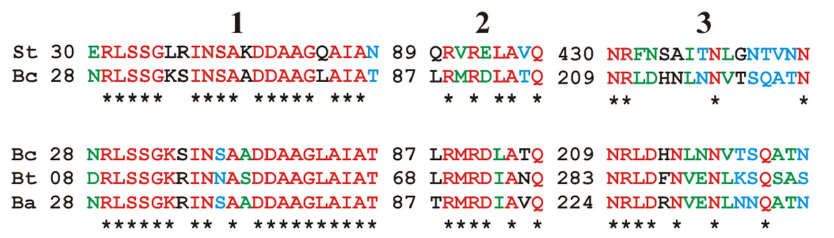
Figure 7. Multiple sequence alignments of S.typhimurium , B.cereus , B.thuringiensis , and B.anthracis flagellins. The amino acid sequences of B. cereus (Bc) and S. typhimurium (St) (top) and Bc, B. thuringiensis (Bt), and B. anthracis (Ba) (bottom) were aligned by ClustalW [71], focusing on regions important for IL8 activity (Region 1) and TLR5 stimulation and recognition (Regions 2 and 3). Asterisks and red letters identify amino acids conserved between Bc and St sequences or among Bc/Ba/Bt sequences. Blue amino acids have strongly similar properties, while green amino acids have weakly similar properties. Bc and St had 81% conserved residues in Region 1, 62.5% conserved residues in Region 2, and 25% conserved residues in Region 3. Bc, Ba, and Bt had 86% conserved residues in Region 1, 62.5% conserved residues in Region 2, and 44% conserved residues in Region 3.